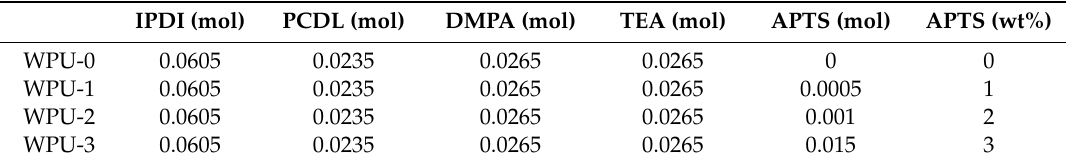
Table 1. Molar ratio of raw materials for the synthesis of WPU. IPDI: isophorone diisocyanate, PCDL: polycarbonate diols, DMPA: 2,2-dimethylolpropionic acid, TEA: triethylamine (TEA),